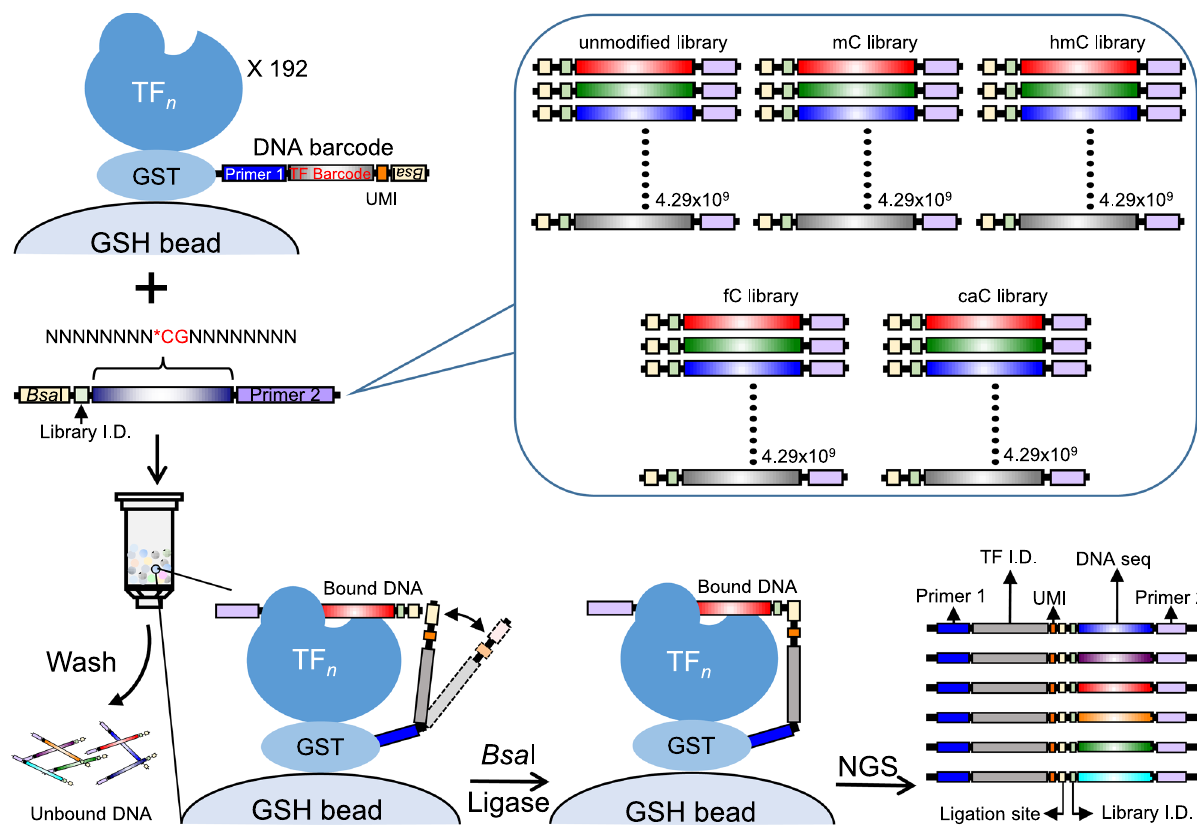
Fig. 1 Schematics of identifying epigenetic modi fi cation readers by DAPPL. Principle and execution of the digital af fi nity pro fi ling via proximity ligation (DAPPL) approach. The principle of the DAPPL approach is to utilize the unique DNA barcodes tethered to TF proteins as identi fi ers to de-convolute the DNA sequences that a given TF captures in a highly multiplexed binding assay. First, each puri fi ed TF protein on glutathione beads was individually conjugated with a unique DNA barcode. Second, barcoded TF proteins on beads are mixed and incubated with a mixture of fi ve randomized DNA libraries (the multicolored middle bricks of each DNA means various randomly synthesized DNA sequence species) carrying either symmetric or hemi- modi fi cations. Third, after removal of unbound DNA fragments, a TF-capture DNA fragment can be ligated to the DNA barcode conjugated on that particular TF via Golden Gate Assembly due to the close proximity of the TF barcode DNA. Fourth, the ligated products can be PCR-ampli fi ed by utilizing the constant sequences attached to the TF barcodes and one end of the DNA library. Finally, the sequences obtained with Next-Generation sequencing will be de-convoluted and analyzed with our bioinformatics tools (see Supplementary Fig. 3 for more